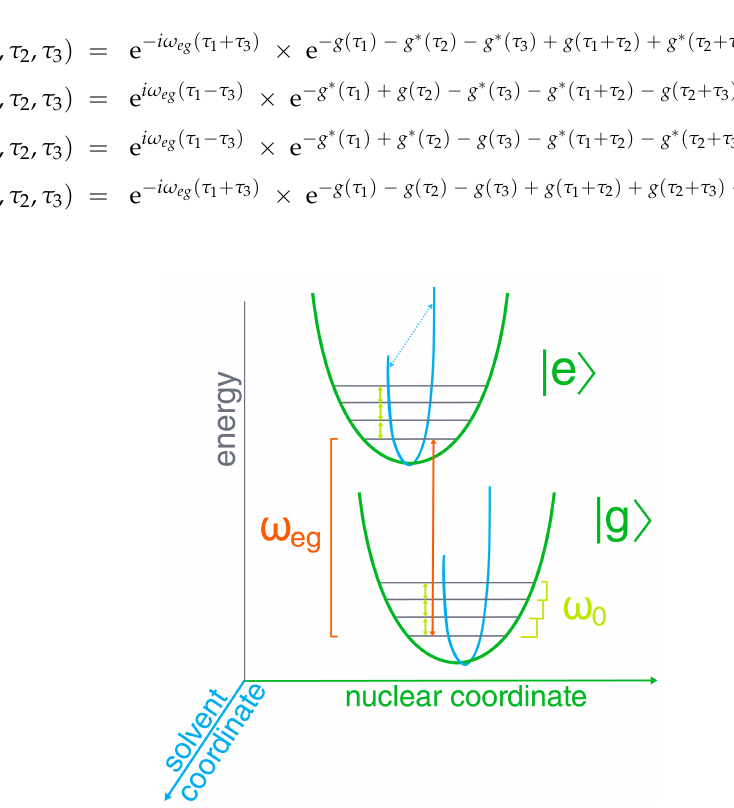
Figure 1. Two-level system of harmonic oscillators used to model a sample with electronic states | g (cid:105) and | e (cid:105) (green) in the presence of a solvent environment (blue). Excitation induces an electronic transition (red) between | g (cid:105) and | e (cid:105) , which are separated by a frequency gap of ω eg . Nuclear modes, or vibrational transitions (light green) with characteristic frequencies indicated by ω 0 , also occur. Vibronic coupling takes place as coupling between the vibrational transitions and the electronic